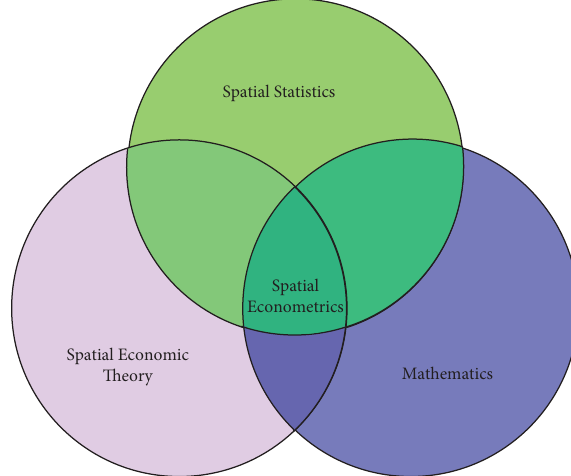
Figure 1: Spatial econometric compositions.